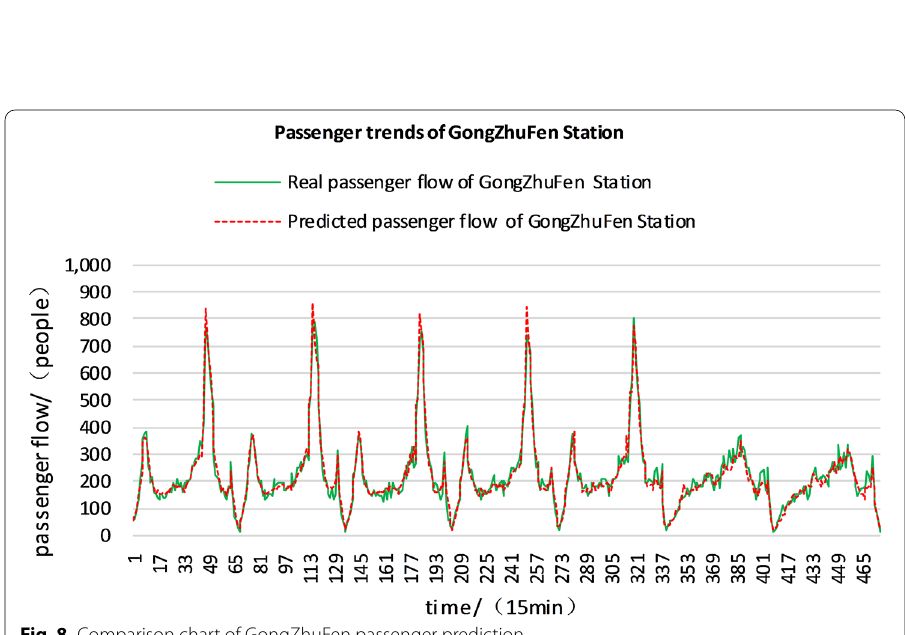
Fig. 8 Comparison chart of GongZhuFen passenger prediction